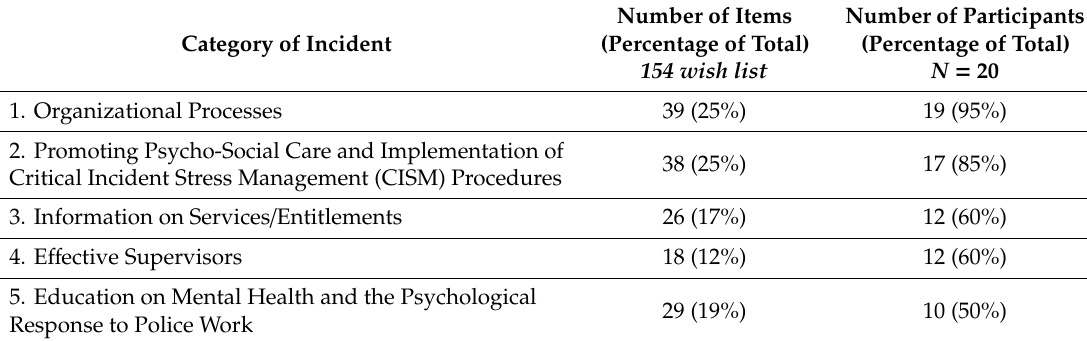
Table 3. Wish List